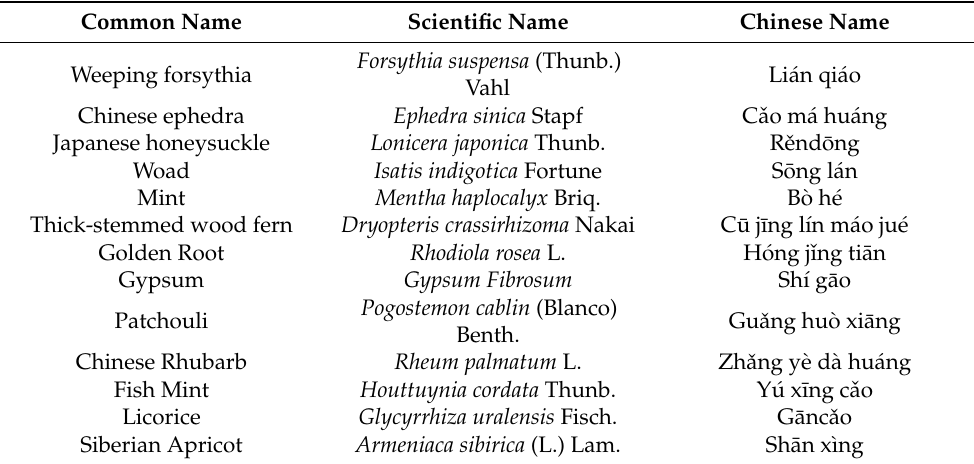
Table 2. Herbs involved in Lianhuaqingwen, used in traditional Chinese medicine to suppress SARS-CoV-2